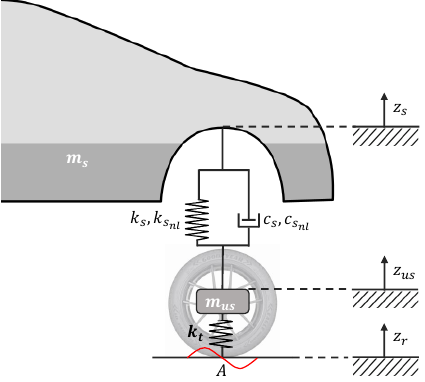
Figure 1. Quarter car